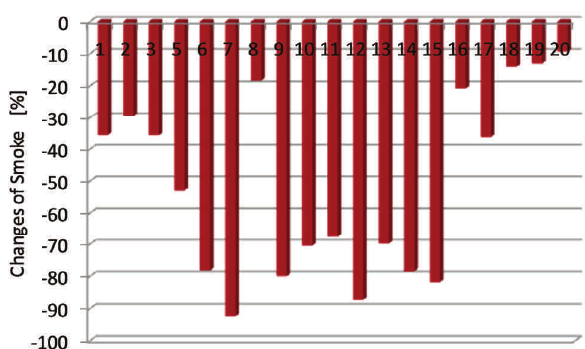
Fig. 3. Changes of smoke in exhaust gases of dual fuel engine at points simulating NEDC test in relation fueling with pure Diesel oil: correction of air output, opening time of gas injector 2.0 ms